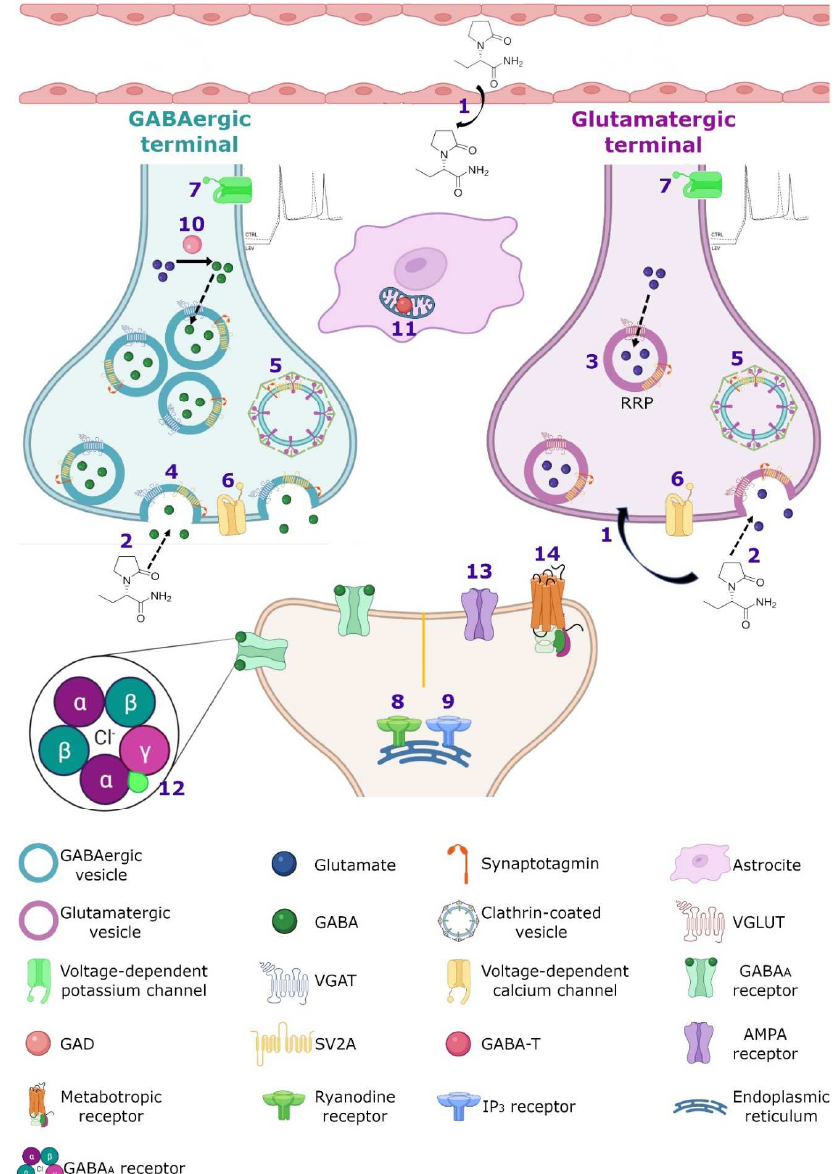
Figure 4. Hypothetical integrated molecular mechanisms of action of LEV. ( 1 ) LEV diffuses through- out the blood–brain barrier and neuron membrane or enters during ( 2 ) exocytosis and endocytosis processes, subsequently exerts its action by various mechanisms. ( 3 ) LEV could decrease the function of SV2A during vesicular priming and thus diminishes the readily releasable pool and therefore the release of neurotransmitters (purple terminal). Another possibility is that LEV stabilizes SV2A and improves its function during ( 4 ) exocytosis, and ( 5 ) endocytosis modulating the expression and traffic of synaptotagmin protein. ( 6 ) Moreover, it has been reported that LEV blocks the voltage- dependent calcium channels, decreasing the synaptic transmission. ( 7 ) LEV reduces potassium currents inducing a decrease in the repetitive action potential generation. With respect to calcium intracellular systems, LEV reduces the calcium transients of ( 8 ) ryanodine and ( 9 ) IP 3 receptors. In the GABAergic system, LEV modulates the region-dependent ( 10 ) glutamic acid decarboxylase (GAD) and increases ( 11 ) GABA transaminase (GABA-T). In the post-synapse, LEV blocks the effect of the ( 12 ) GABA A receptor antagonists. In the glutamatergic synapse, LEV modulates ( 13 ) AMPA receptors and decreases the excitatory current. ( 14 ) Finally, LEV interacts with noradrenaline, adenosine and serotonin receptors in post-synapse involved in pain